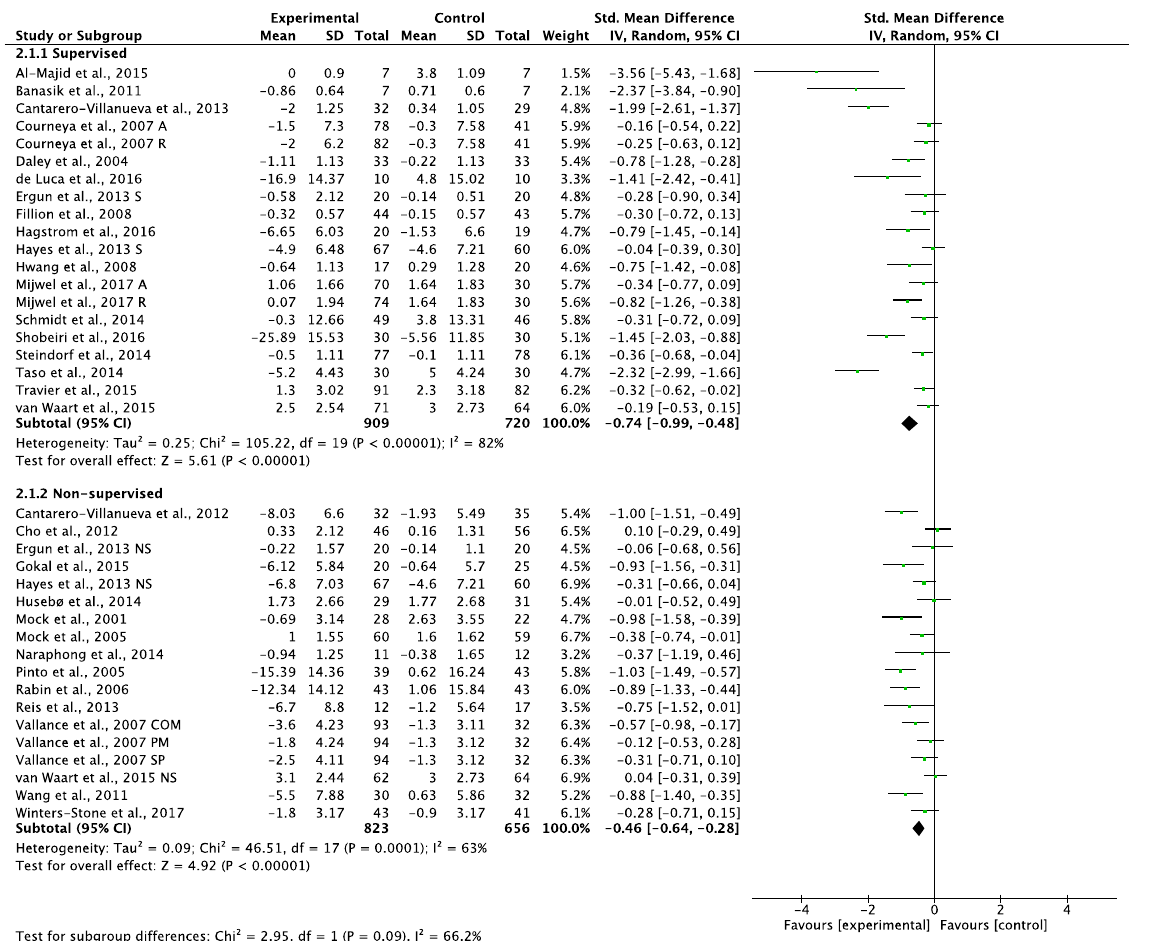
Figure 4. Meta-analyses of the effects of supervised [35,43,44,46–53,55,56,58,59,61,63,64] and non- supervised exercise [36–42,45,49,51,54,57,59,60,62,65] in CRF. A: aerobic exercise group; COM: com-